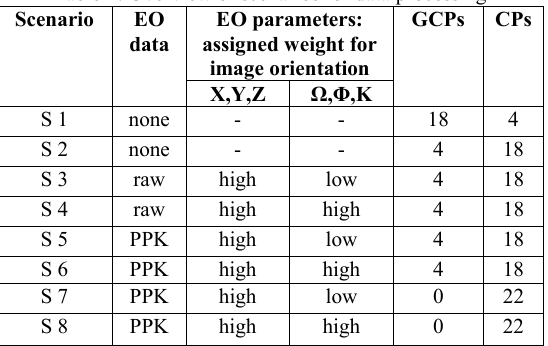
Table 1: Overview of scenarios for data processing